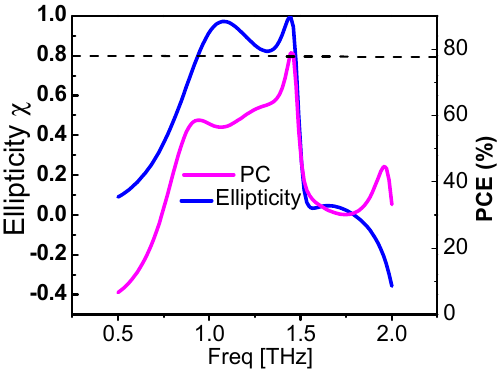
Figure 6. Ellipticity for the transmitted wave with incident x polarized wave.